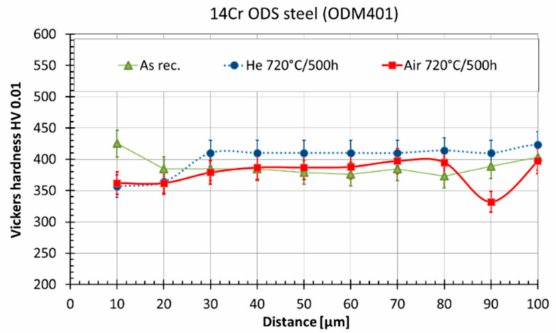
Figure 11. Vickers micro-hardness profiles in the sub-surface region; comparison of AR, Air720, and He720 including the standard 5%